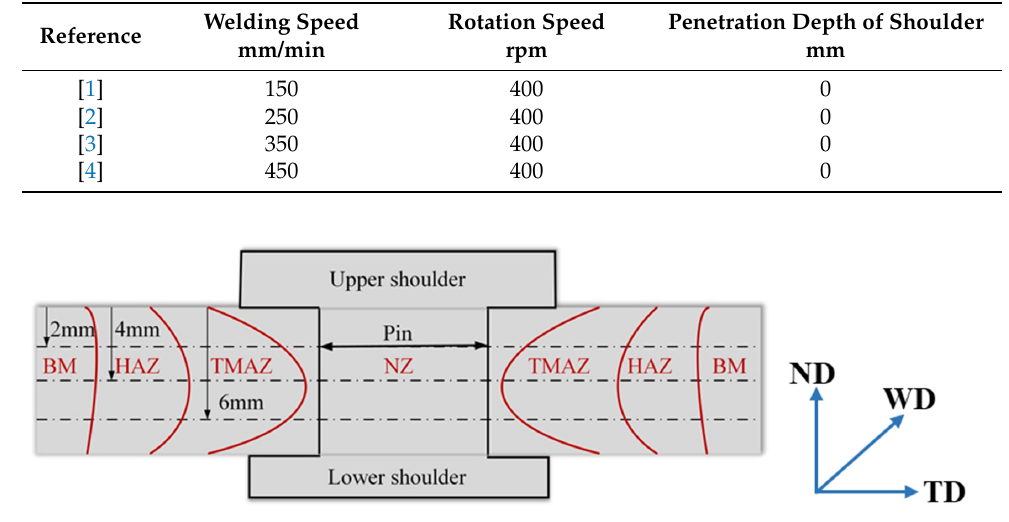
Figure 2. Schematic illustration for the microhardness measurement points. Table 2. The Experimental Conditions.